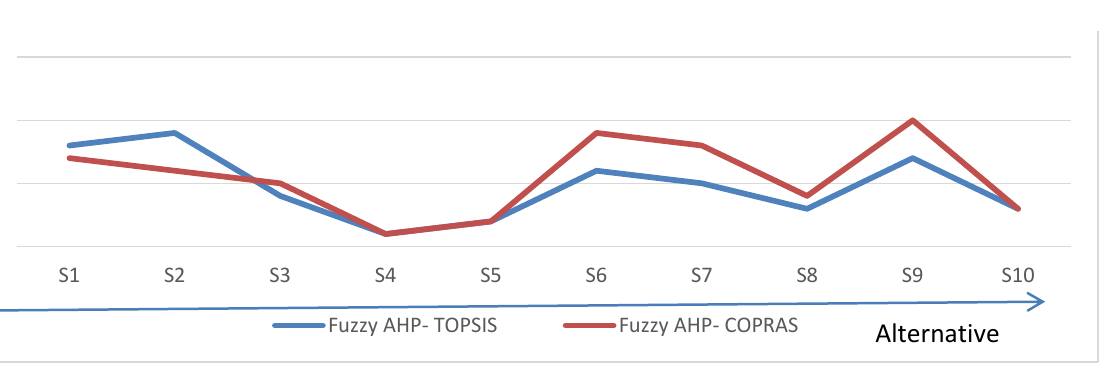
Figure 10. Representation of the ranking obtained under the two MCDM techniques.